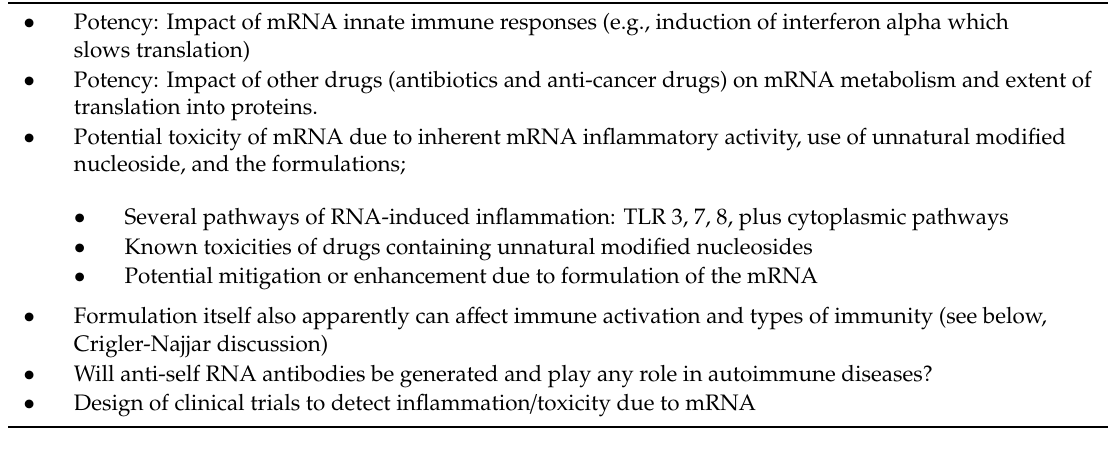
Table 2. Issues to be addressed for clinical e ffi cacy and safety of mRNA related to